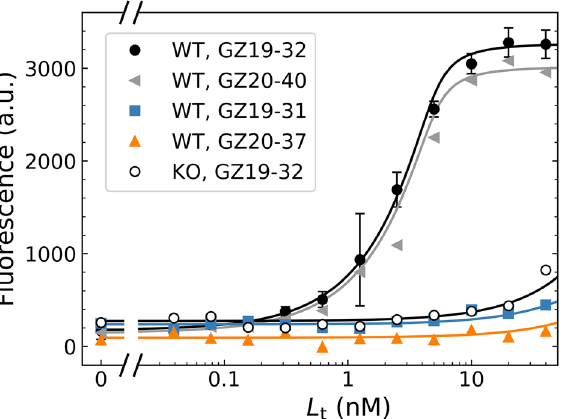
Figure 8. Quantitative dosing of the fluorescein-labeled compounds to HeLa cells (grown for 72 h under hypoxia). Dosing of GZ19-32 or GZ20-40 yielded similar dosing profiles (data points) with the lines fitted to the Morrison